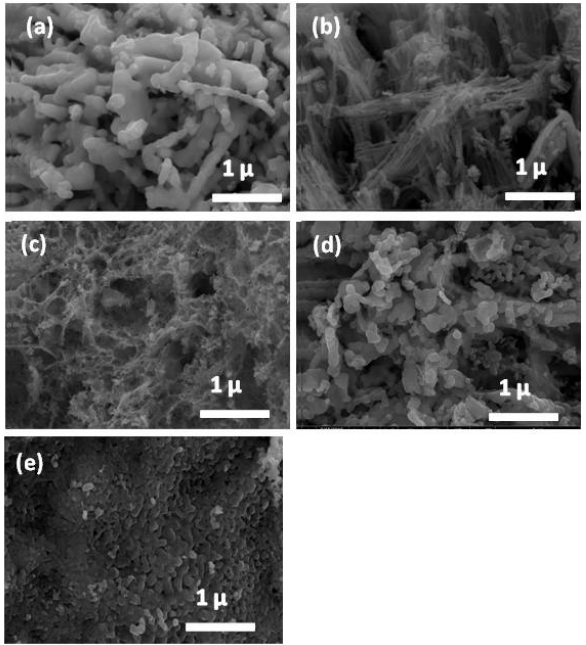
Figure 2. FE-SEM micrographs of ( a ) sample LSM2; LSM at 0.2 Sr 2+ ion, ( b ) sample LSM5; LSM at 0.5 Sr 2+ ion, ( c ) sample LSM8; LSM at 0.8 Sr 2+ ion, ( d ) sample LSM Sm; La 0.3 Sm 0.2 Sr 0.5 MnO 3 , ( e ) sample LSM Gd; La 0.3 Gd 0.2 Sr 0.5 MnO 3 , synthesized through a citrate precursor pathway annealed at 1000 °C for 2 h.